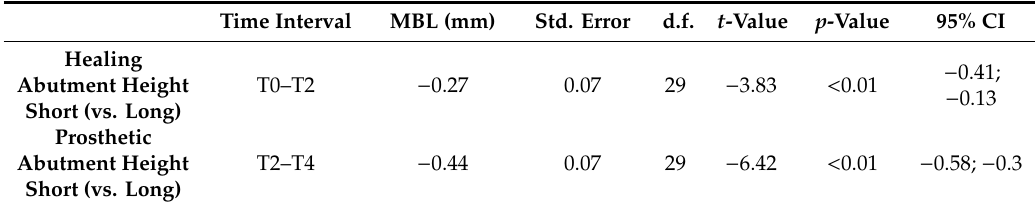
Table 4. Multivariable linear mixed models, analyzing factors influencing marginal bone loss within specific time frames.